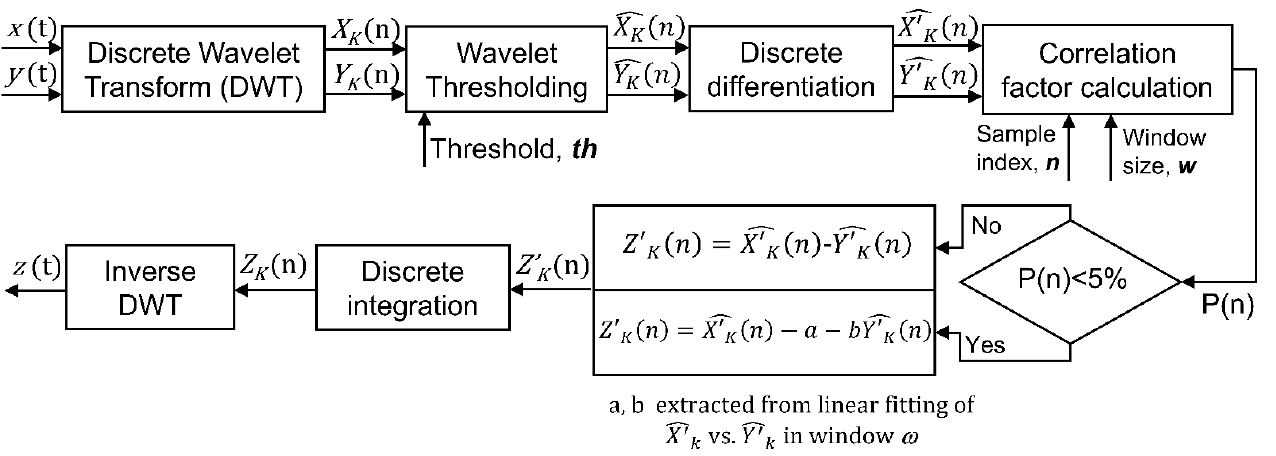
Figure 2. Flow diagram describing the different steps of the